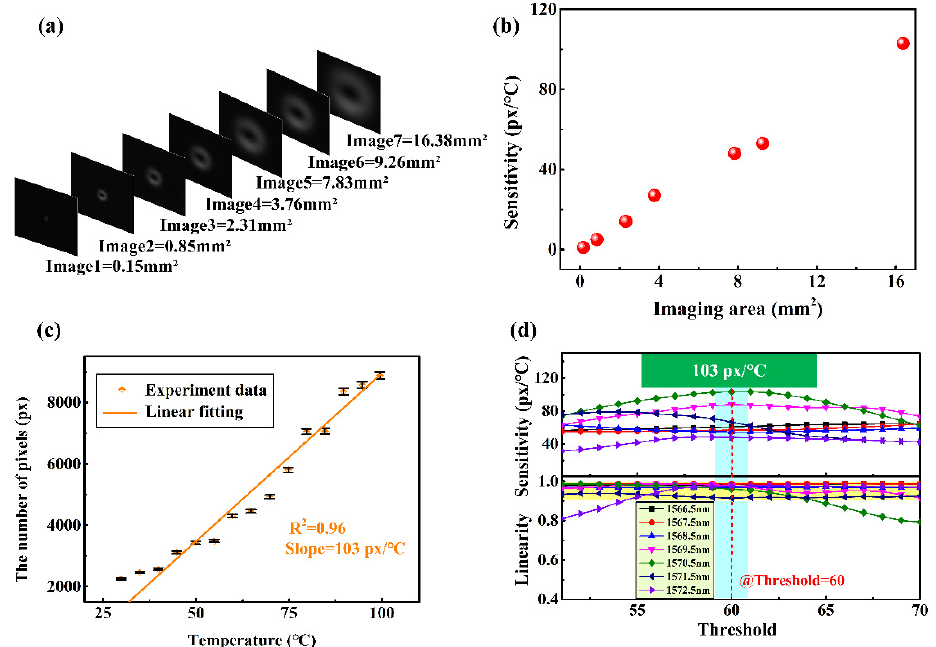
Figure 6. ( a ) The collected images with different imaging area; ( b ) the sensitivity changes with re- spect to the different imaging area. ( c , d ) Experiment data with imaging area 16.38 mm 2 in tempera- ture increasing: ( c ) experiment data of temperature test and its linear fitting; ( d ) the evolution of sensitivity and linearity with different operation wavelength and threshold.